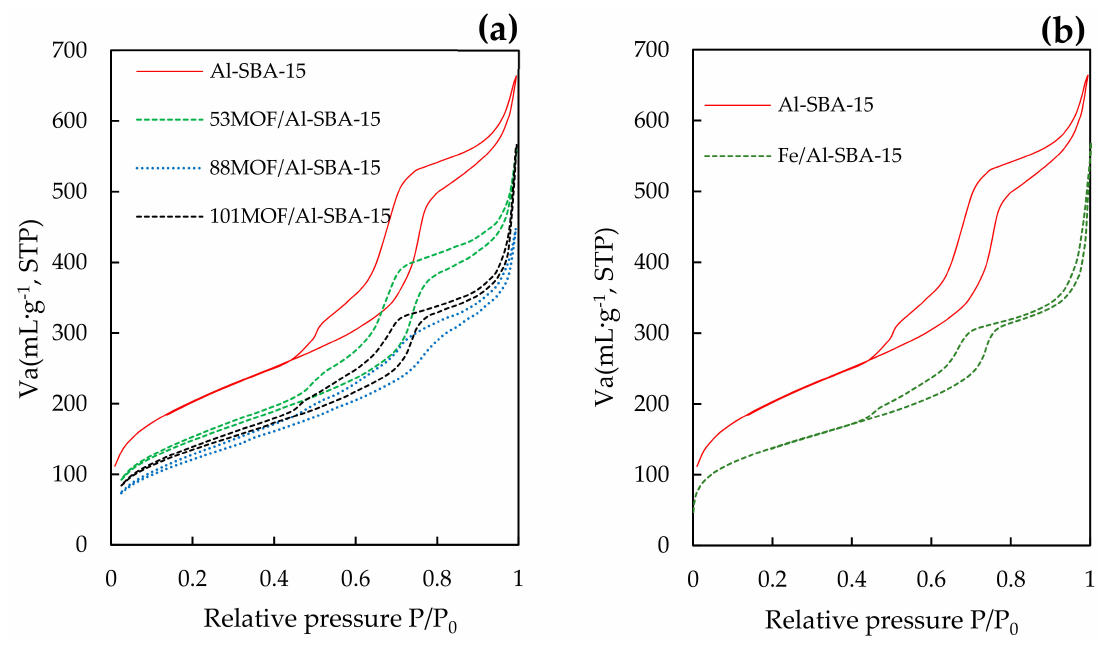
Figure 1. Nitrogen adsorption / desorption isotherms of ( a ) 53MOF / Al-SBA-15, 88MOF / Al-SBA-15 and 101MOF / Al-SBA-15 and ( b ) Fe / Al-SBA-15. Table 1. Textural and surface acid properties of synthesized